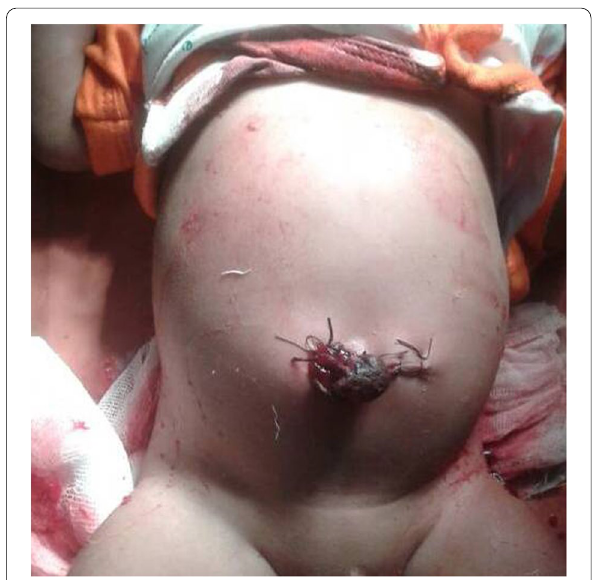
Fig. 2 Clinical photograph after reduction of gut loops with stoma on the abdominal